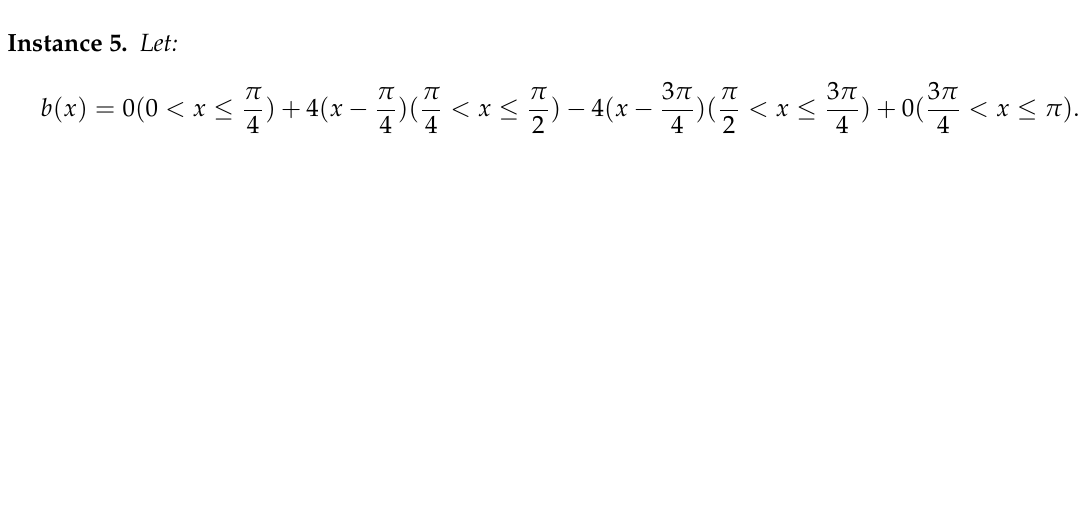
Figure 5. The analytic solution b ( x ) and the regularized solution b δ α =